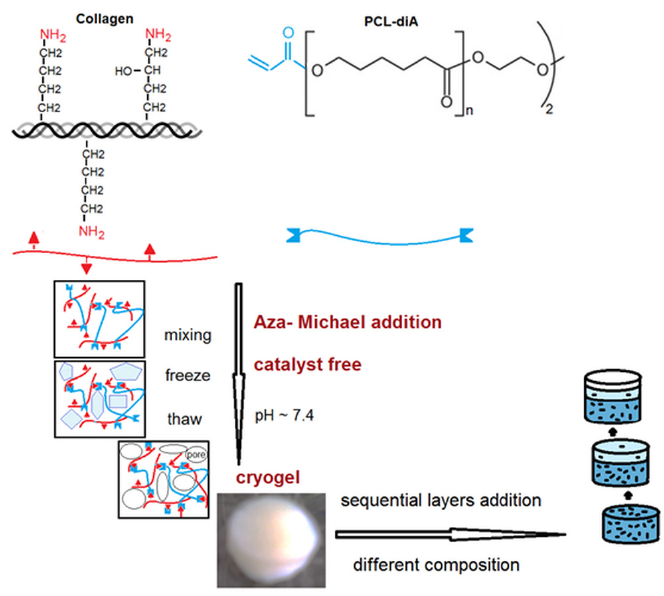
Scheme 1. Schematic representation of the cryogels’ synthesis strategy.